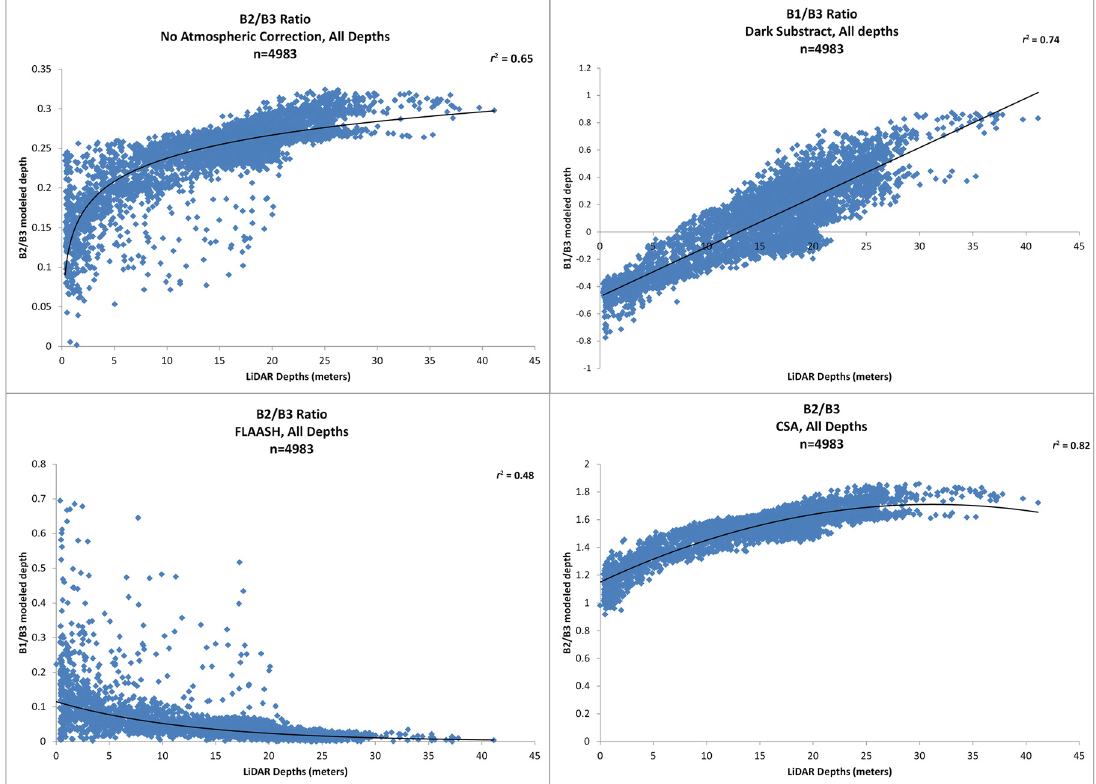
Figure 6. Coefficient of determination and best models to determine an equation of best fit for the relationship between the band ratios of WV2 image and LiDAR SHOALS data. The correlations presented are for no atmospheric correction ( Top Left ), the dark subtract atmospheric correction ( Top Right ), the FLAASH atmospheric correction ( Bottom Left ), and the CSA atmospheric correction ( Bottom Right ).